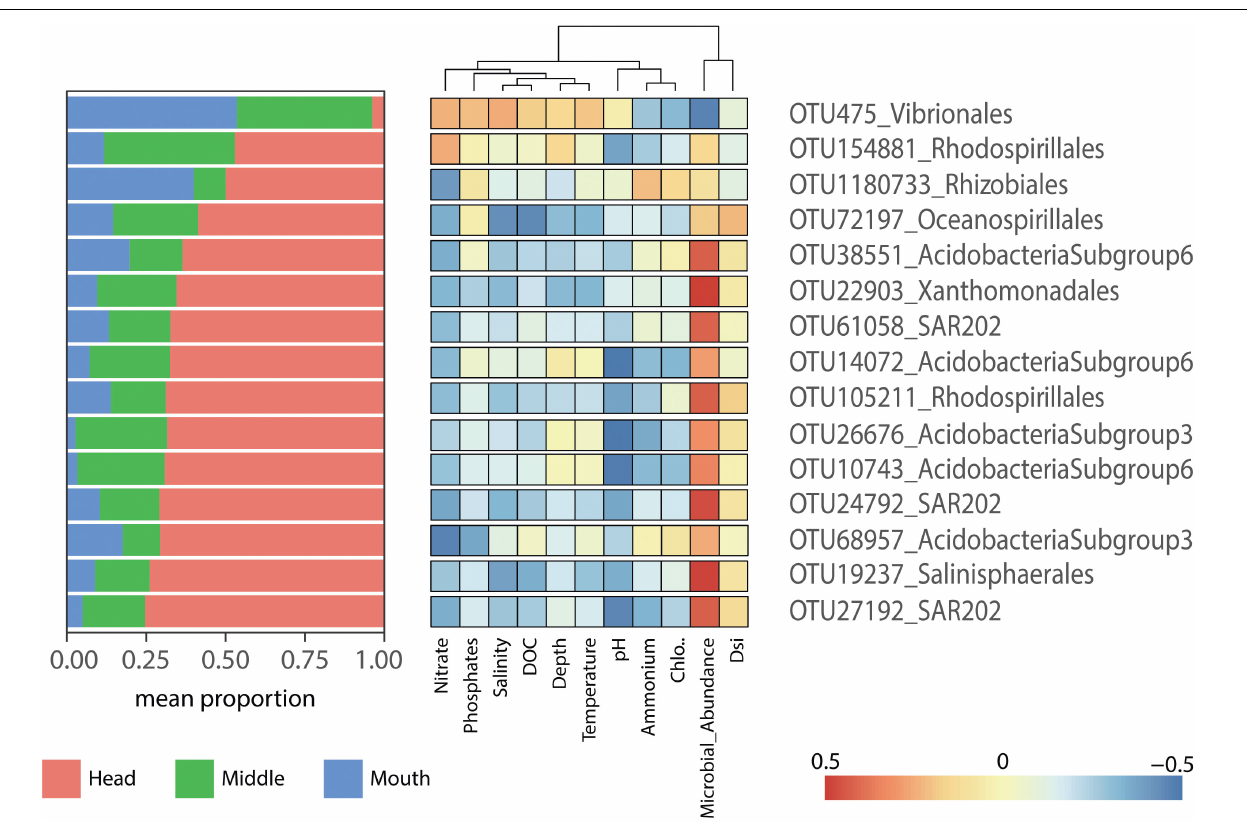
FIGURE 6 | Heatmap displaying the indicator species ( p = 0.001) for the Pia fjord. The left panel shows the mean relative contribution of the indicator species to the microbial communities by station (head, middle, and mouth). The right panel shows a heatmap of Pearson correlations between indicator species (OTU abundance) and environmental